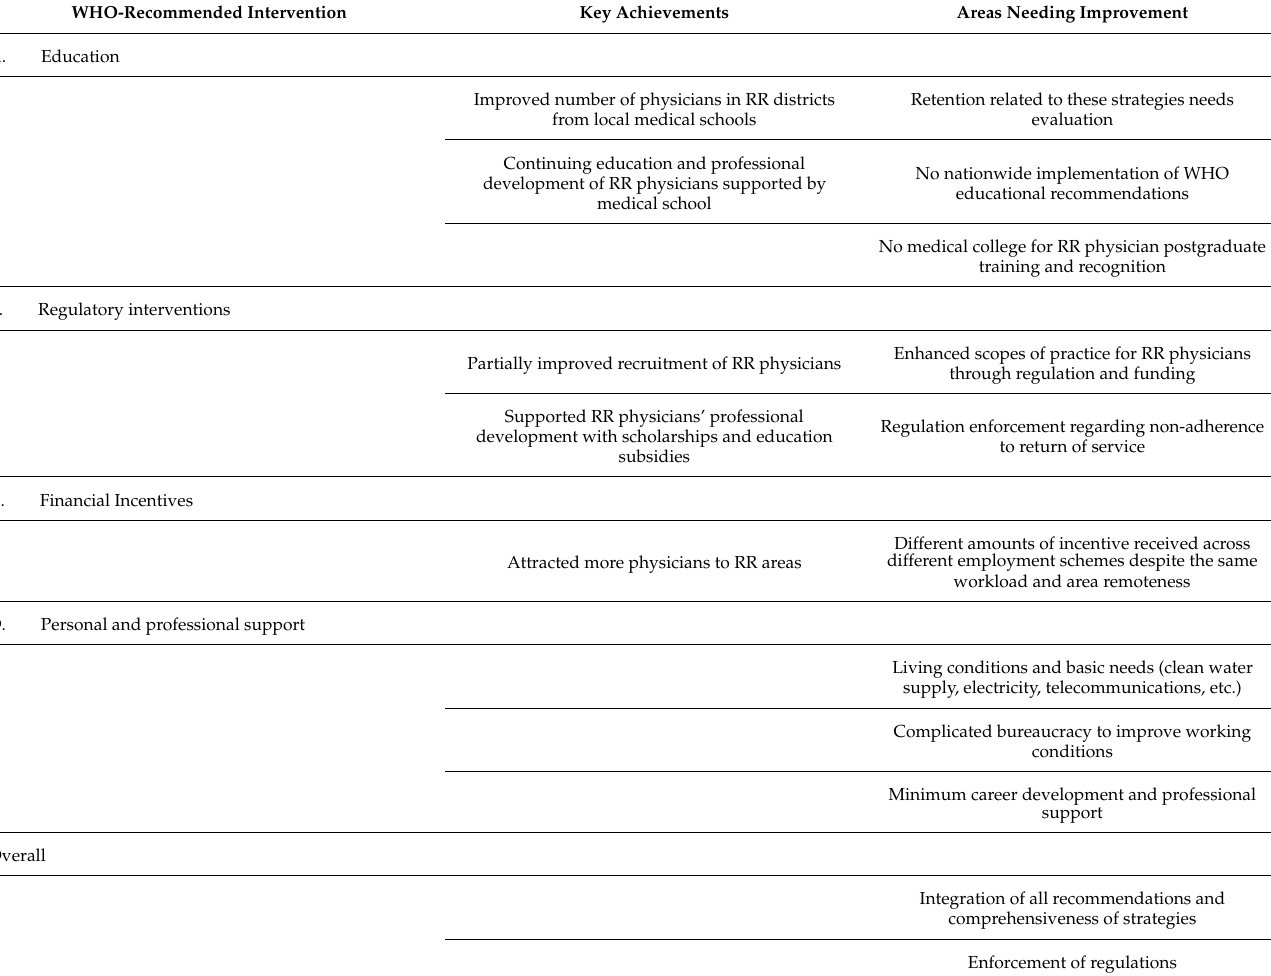
Table 1. Summarised key achievements and areas that needed